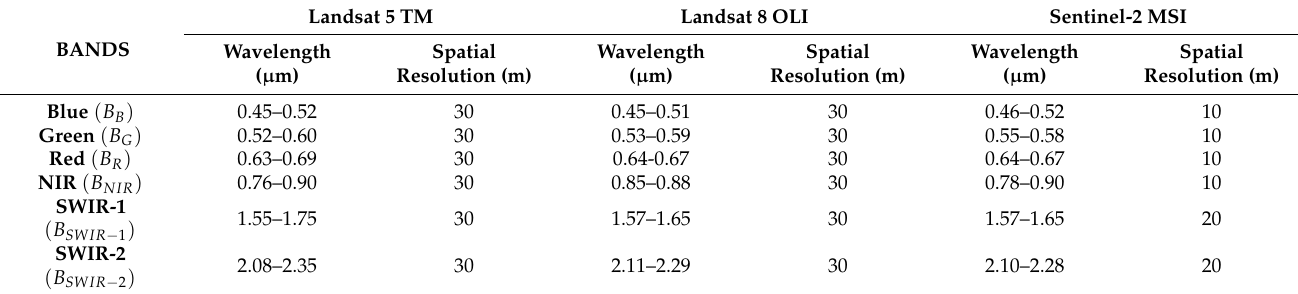
Table 2. The wavelength and spatial resolution specifications of the bands used for estimating the Snow Cover Indexes for the Landsat 5 TM, Landsat 8 OLI, and Sentinel-2A imagery [35,36]. Note: The spatial resolution specifications are referred to one pixel.